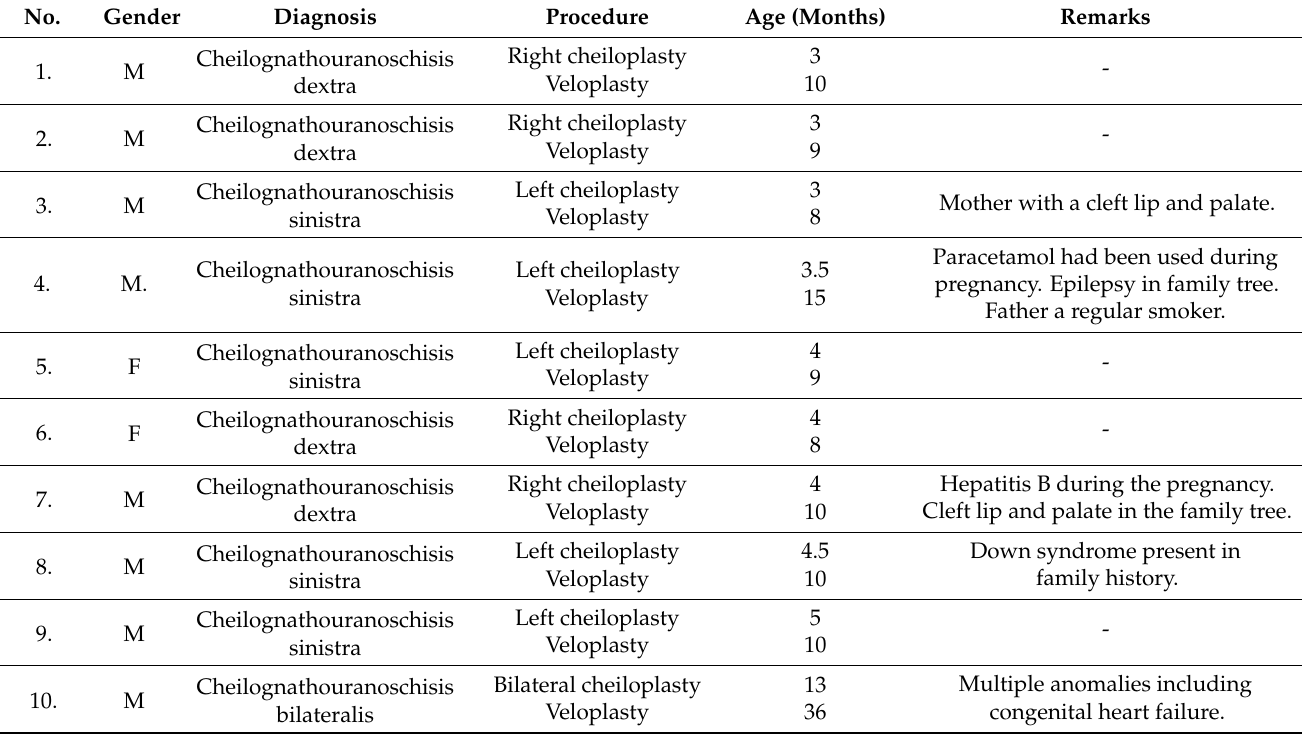
Table 1. Information about the